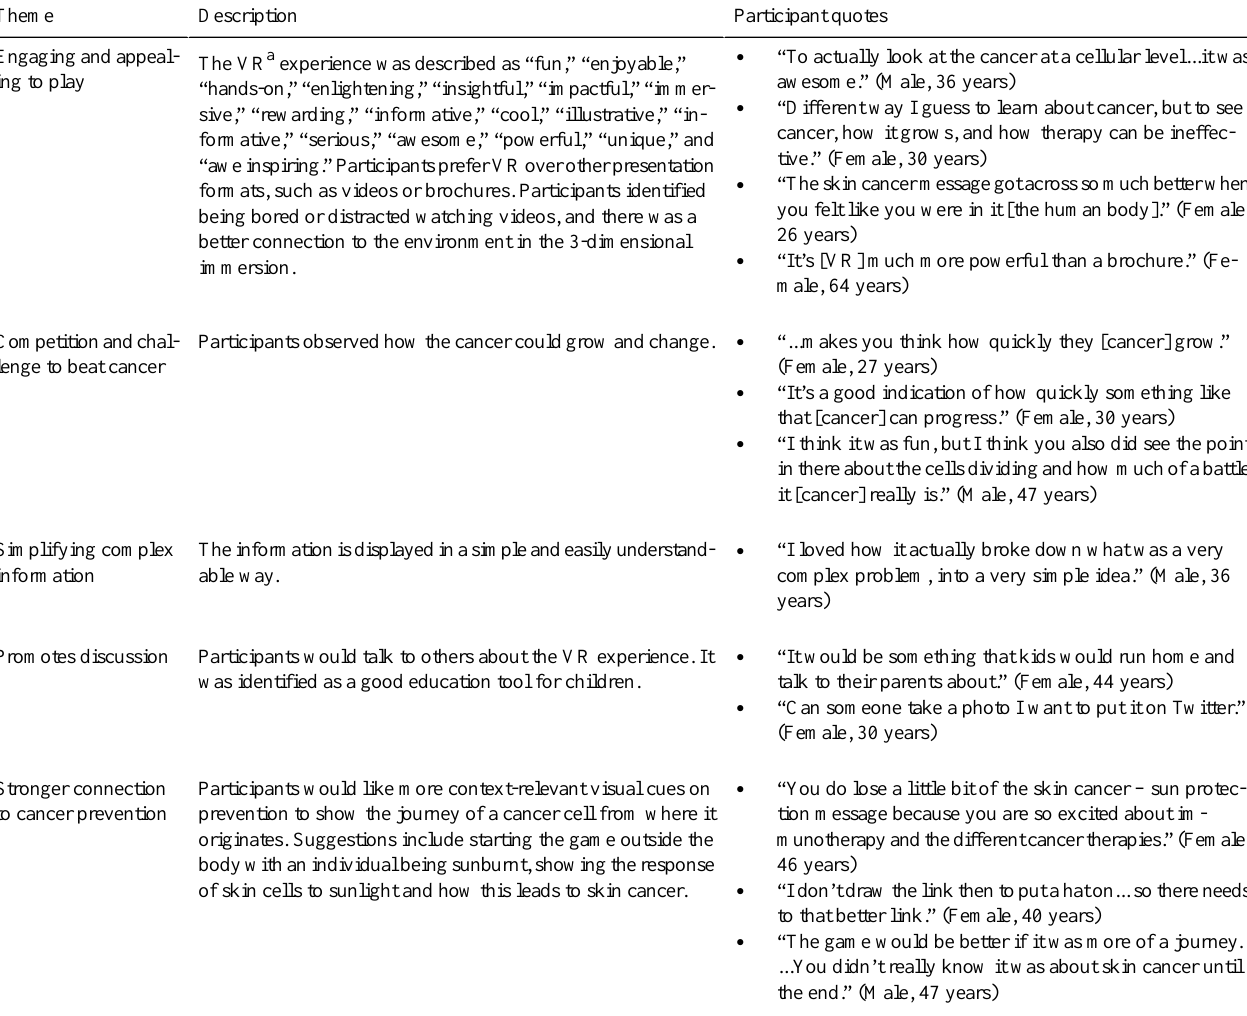
Table 3. End user focus group qualitative analysis themes and